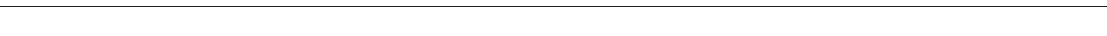
Fig. 1 Knockdown of RLRs and MAVS enhances KSHV lytic reactivation in iSLK.219 cells. a Schematic of RLR-MAVS signaling pathway. b iSLK.219 cells were transfected with indicated siRNAs for 48 h and then treated with Dox for 72 h. GFP and RFP were imaged 48 h post-Dox treatment. Bar indicates 750 μ m. c RFP positive cells were quanti fi ed by fl ow cytometry 48 h post-Dox treatment. d RNA extracted from iSLK.219 24 h post-reactivation and expression of the indicated genes was quanti fi ed by RT-qPCR. e Western blot analysis of cell lysate from latent and 48 h post-Dox treatment iSLK.219 cells described in ( b ). f HEK293T cells were infected with supernatants of reactivated iSLK.219. GFP images were captured 48 h postinfection. Bar indicates 300 μ m. g Quanti fi cation of GFP positive cells in ( f ). h RNA was extracted from HEK293T cells in ( f ) and KSHV LANA gene expression was monitored by RT-qPCR. i Western blot analysis of cell lysates from latent and 24 h post-Dox treatment iSLK.219 cells in ( b ). Error bars in all panels represent mean ± SD from three independent experiments. p Values were determined by the Student ’ s t test, * p < 0.05, ** p <